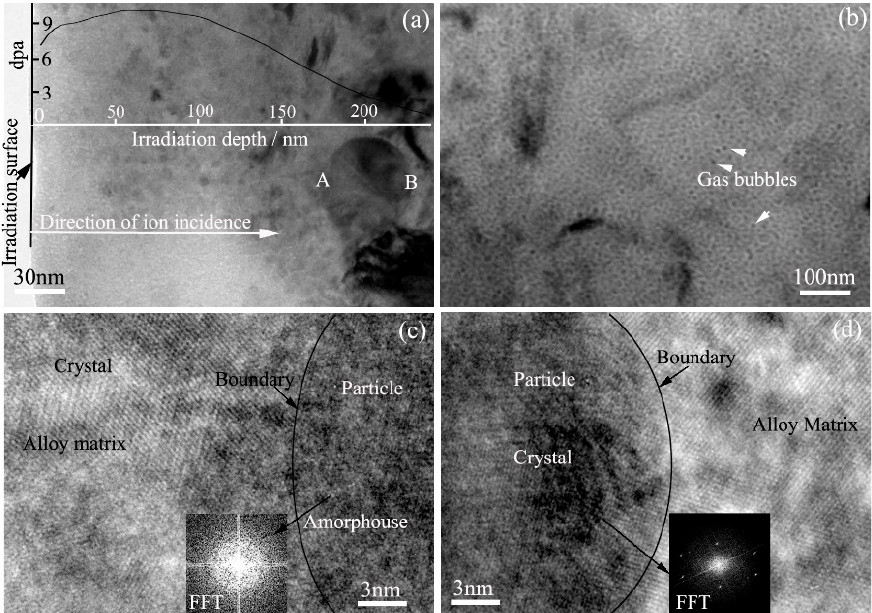
Figure 4 TEM bright field images showing the microstructure of Zr alloy #2 irradiated with 2.86 × 10 15 2.86 × 10 15 Kr + /cm 2 fluence at 320 ◦ C. ( a ) Low magnification of an under-focused TEM image; Kr + /cm 2 fluence at 320 °C. ( a ) Low magnification of an under-focused TEM image; ( b ) Over-focused ( b ) Over-focused TEM image showing gas bubbles; ( c ,d) HRTEM images showing the boundary TEM image showing gas bubbles; ( c ,d) HRTEM images showing the boundary area between a particle area between a particle and the Zr and the Zr matrix.